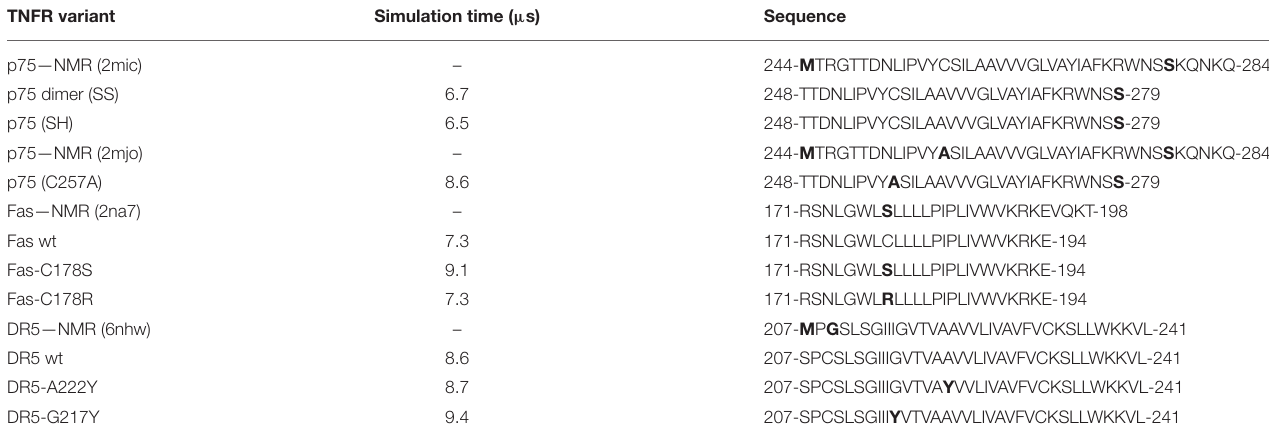
TABLE 1 | Description of the different transmembrane peptides and variants used in the present study, together with the simulation times reached for each